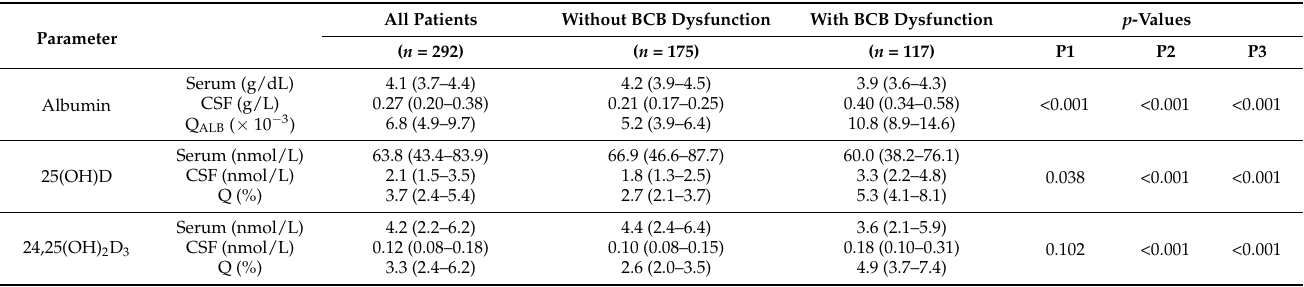
Table 2. Baseline characteristics of the study